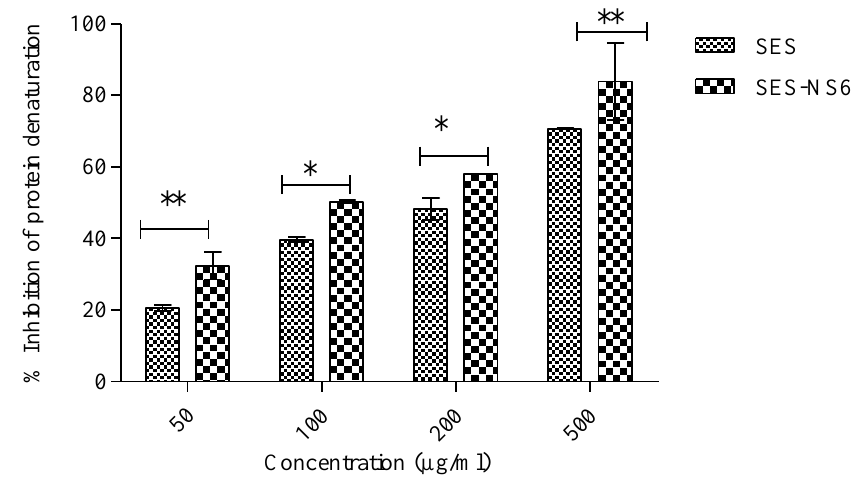
Figure 8. Percentage inhibition of protein denaturation by sesamol (SES) and sesamol-laden nanosponges (SES-NS6). Results are displayed as mean ± SD (n = 6). A two-way ANOVA statistical data analysis was followed by multiple comparisons by Bonferroni post-tests. Statistical significance ** indicates p < 0.001 and * indicates p <